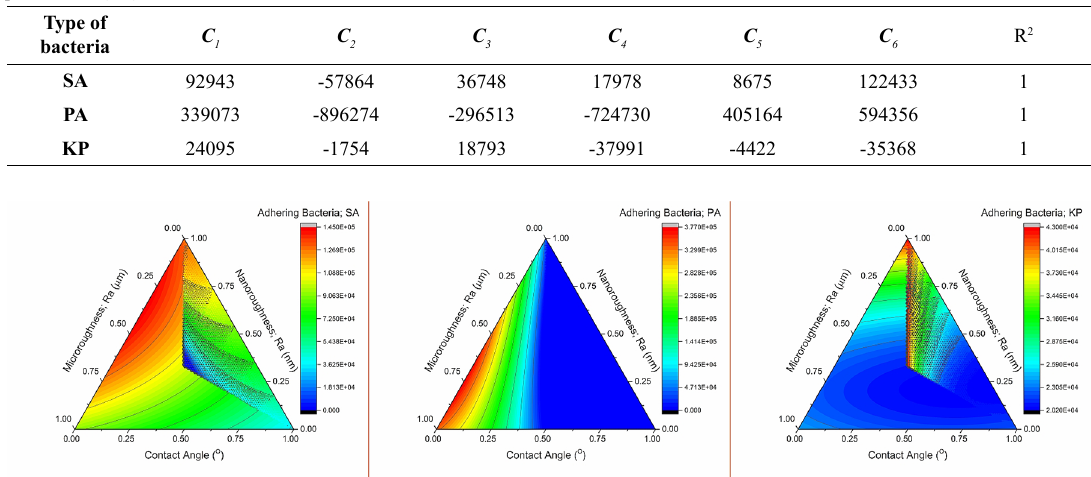
Figure 12. The adhering behavior of the Staphylococcus aureus (SA), Pseudomonas aeruginosa (PA), and Klebsiella pneumonia (KP)